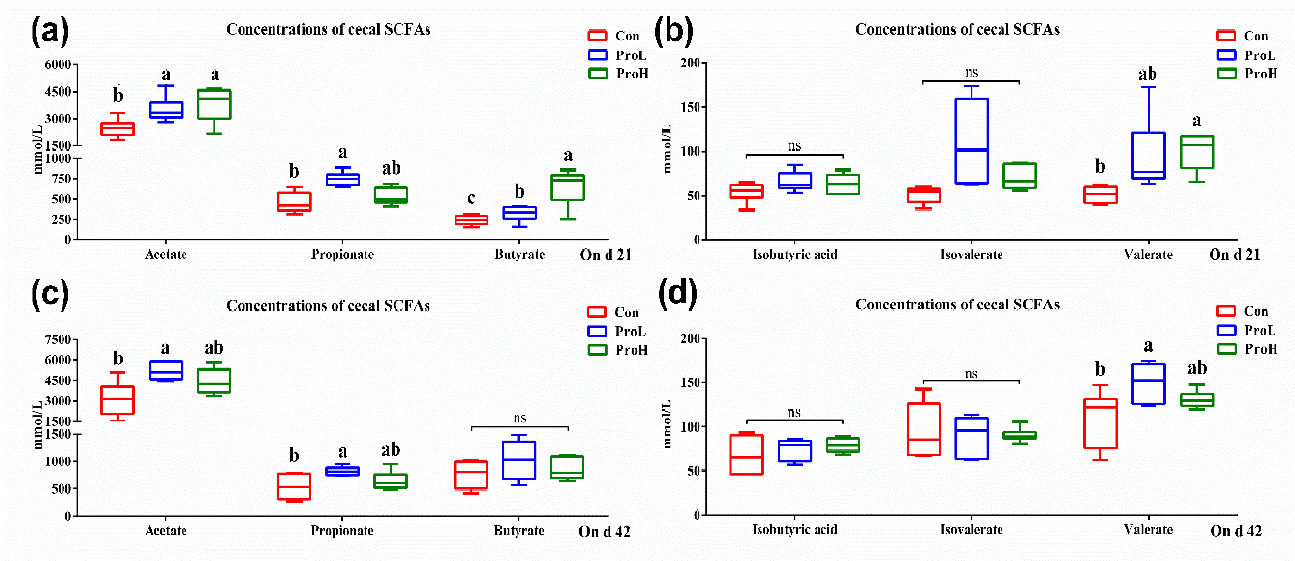
Figure 4. Effects of compound probiotic supplementation on caecal SCFAs concentrations in broilers. ( a ) concentrations of acetate, propionate, and butyrate on d 21; ( b ) concentrations of isobutyric acid, isovalerate, and valerate on d 21; ( c ) concentrations of acetate, propionate, and butyrate on d 42; ( d ) concentrations of isobutyric acid, isovalerate, and valerate on d 42. a, b, and c in the same figure represent significant difference ( p < 0.05); ns represents no significant difference. Con birds were fed a basal diet; ProL birds were fed a basal diet added into 10 10 probiotics cfu/kg; ProH birds were fed a basal diet added into 10 11 probiotics cfu/kg ( n = 8).